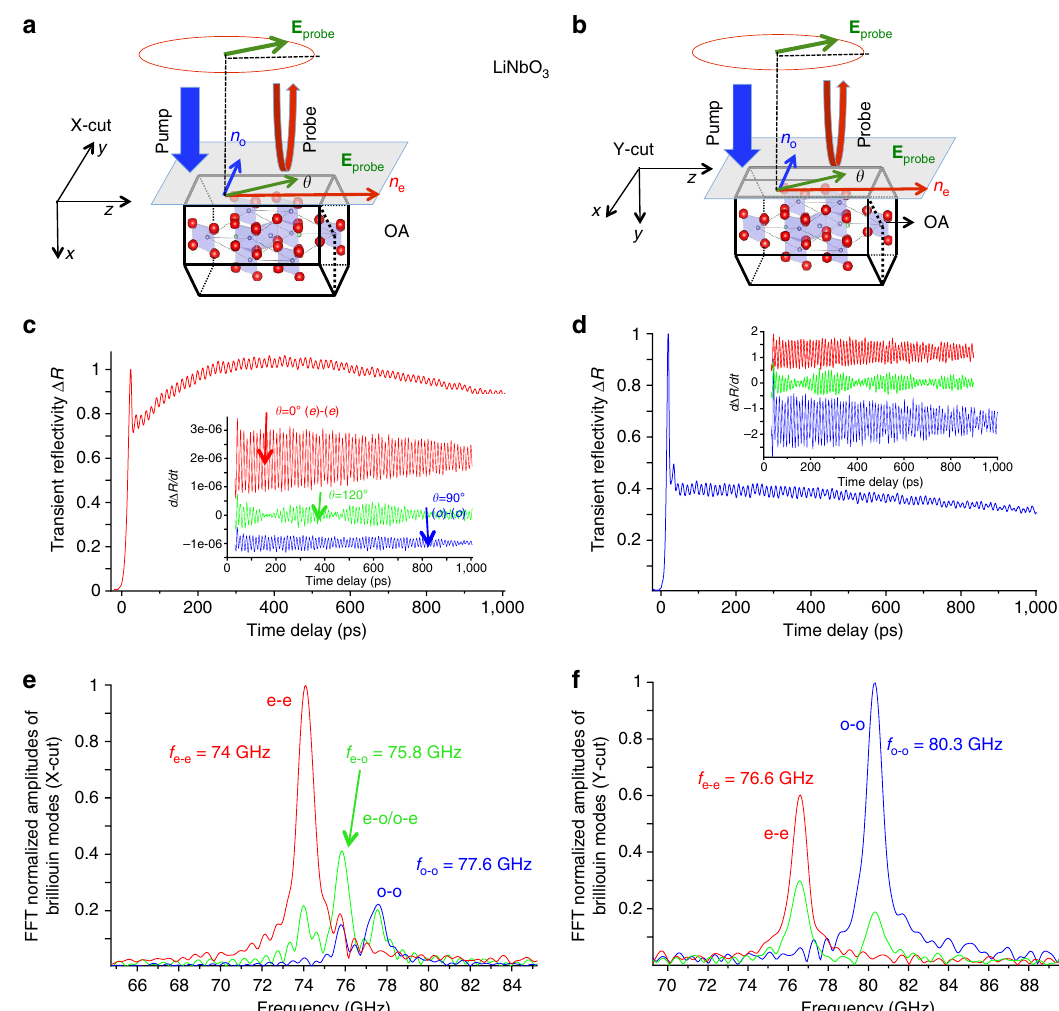
Figure 5 | Ultrafast elasto-optic mode conversion in X - and Y -cut LNO. Sketch of the pump–probe experiment carried out on X - ( a ) and Y -cut ( b ) LNO crystal. ( c , d ) Corresponding time-resolved Brillouin signals with variable probe polarization angle y . The red and blue curves are signals obtained for a probe angle y ¼ 0 (cid:2) and y ¼ 90 (cid:2) , respectively, whereas the green curve corresponds to a signal obtained for the probe angle y ¼ 120 (cid:2) . The insets show the time derivative of the time-resolved Brillouin signals. ( e ) FFTof signals shown in inset of c . The FFTof the time-derivative signal of X -cut LNO ( y ¼ 120 (cid:2) ) reveals in particular the extraordinary/ordinary ultrafast elasto-optic mode conversion ((e)-(o)/(o)-(e)) together with the normal processes ((o)-(o) and (e)-(e)). The FFTof Y -cut LNO time-resolved Brillouin signals are given in f . In agreement with the theory, whatever the probe electric field angle y , the FFT demonstrates the absence of the ultrafast elasto-optic mode conversion ((e)-(o)/(o)-(e)) in the Y -cut crystal, whereas the normal processes ((o)-(o) and (e)-(e)) still